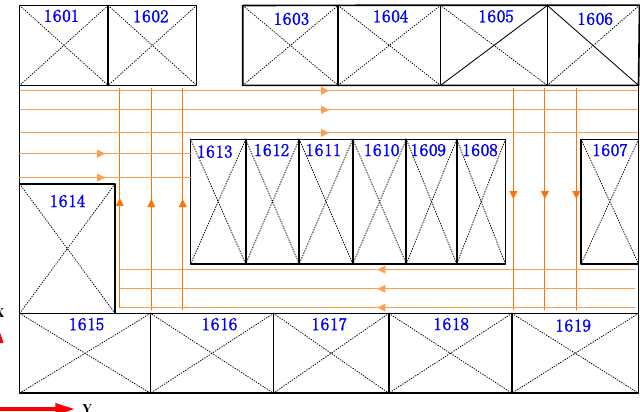
P M  Figure 3. The procedure of training the magnetic map via a walking survey.